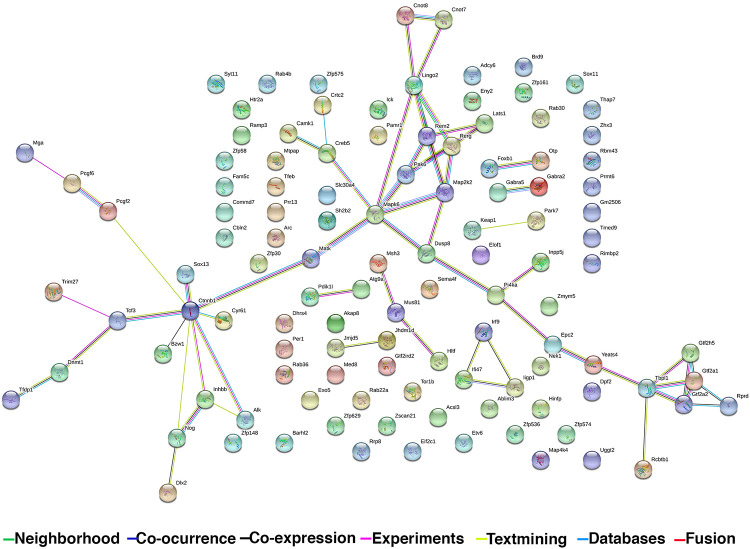
Transcriptional connectome of dual treatment group with associated gene products.(A) Search Tool for the Retrieval of Interacting Genes database (STRING) diagram of functional associations between protein products of unique genes within the H1N1+Mn treatment group. Nodes represent proteins and edges correspond to functional interactions. Edge colors differ according to a scored confidence scale based on the extent and type of evidence supporting that particular association. Evidence channels: Green Line: Neighborhood, Navy Line: Co-occurrence, Black line: Co-expression, Pink line: Experiments, Yellow line: Textmining, Light blue line: Databases, Red line: Fusion.